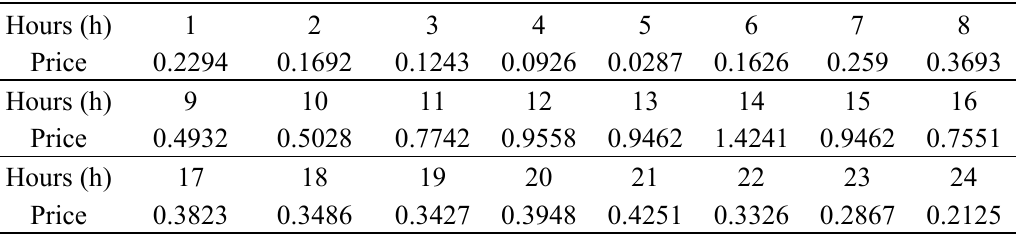
Table 2. Electricity purchasing price (yuan).